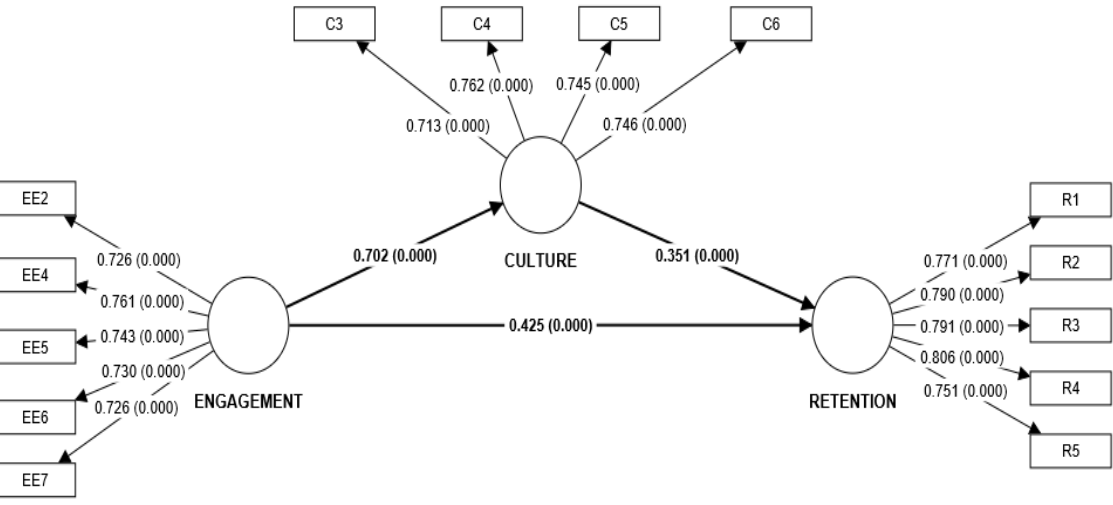
Figure 1. PLS model.